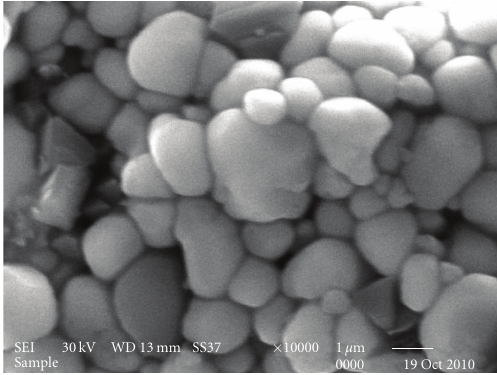
Figure 2: SEM micrograph of composite with x = 0 .